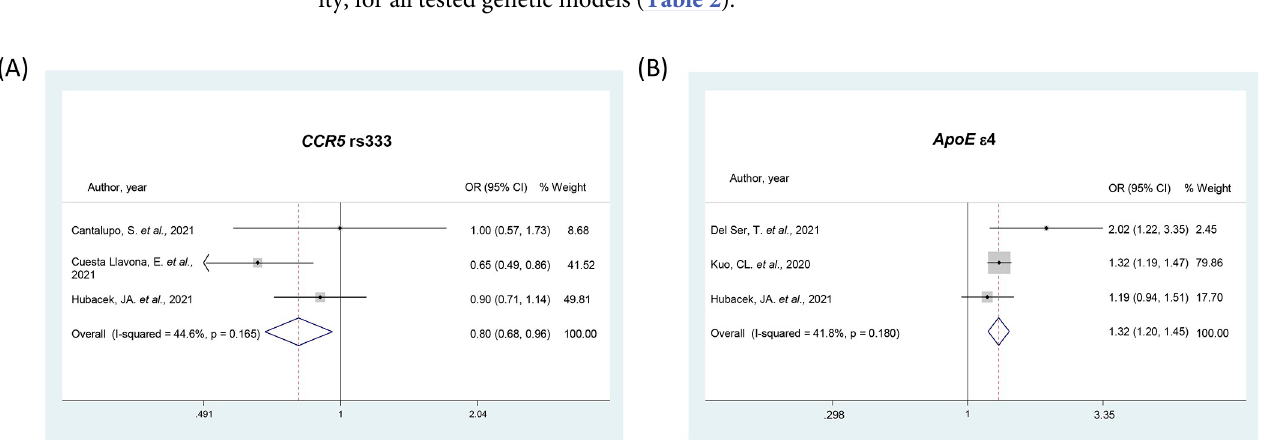
Fig 4. Forest plots showing individual and pooled ORs (95% CIs) for the associations between the CCR5 rs333 ( A ) and ApoE ε 4 ( B ) polymorphisms and COVID-19 presence, both under the allele contrast